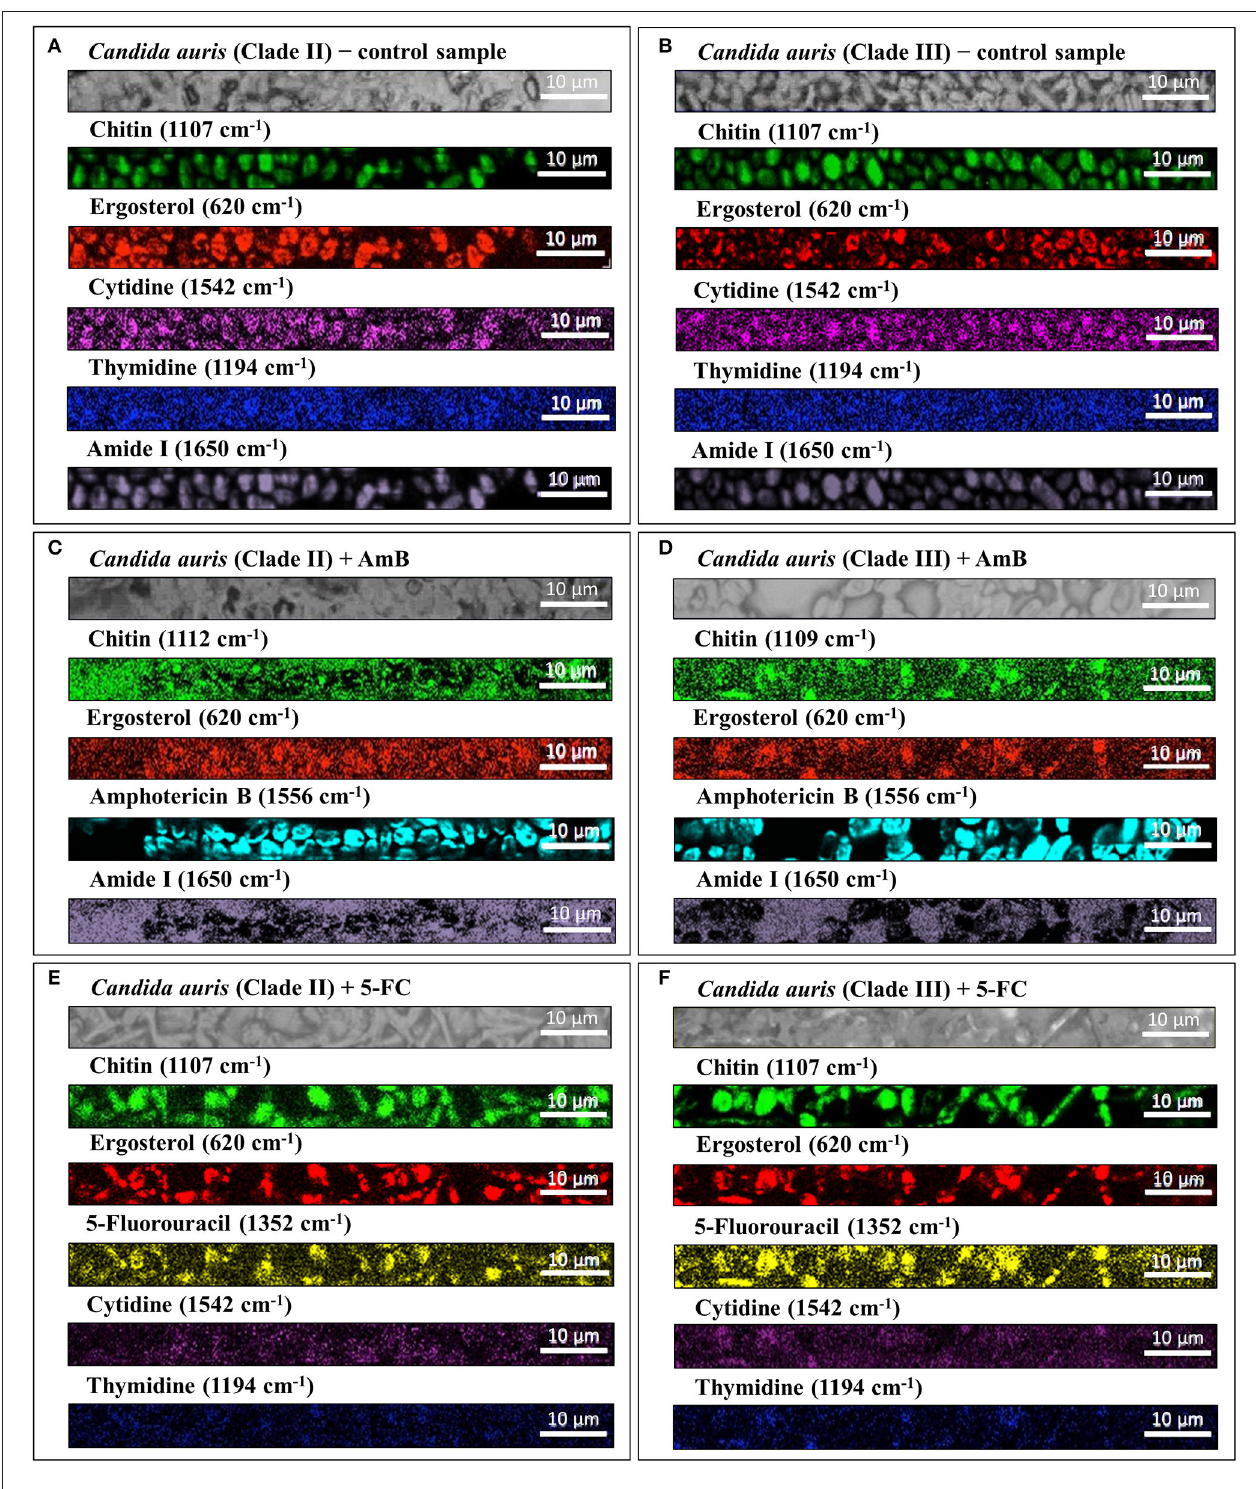
FIGURE 9 | Optical micrographs and spatially resolved Raman data collected on different clades before and after treatments with different drugs; the latter are given as a series of hyperspectral maps for selected molecular markers: (A,B) control, (C,D) AmB-treated, and (E,F) 5-FC-treated Clades II and III, respectively; the targeted molecules (including those of the respective drugs) and the corresponding fingerprint wavenumbers are given by labels in inset to each section. The Raman mapping experiments were in good agreement with and helped to visualize the outputs of average spectral assessments summarized in Figure 8 .